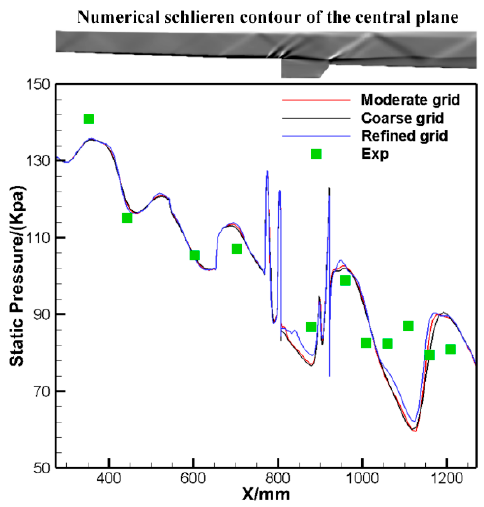
Figure 11. Static pressure distribution comparison of case A-ER0.10 between experiments and numerical simulations.